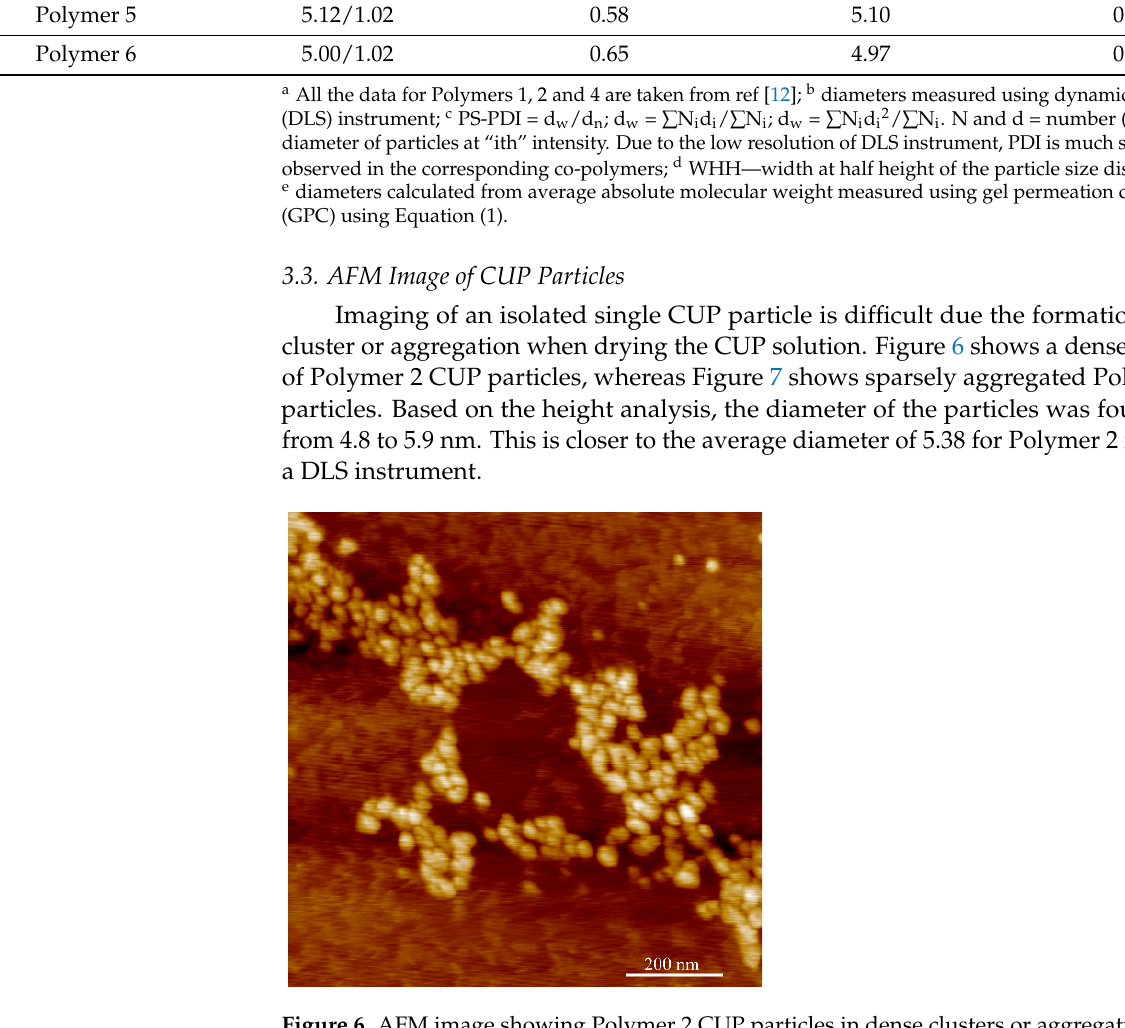
Figure 6. AFM image showing Polymer 2 CUP particles in dense clusters or aggregations.